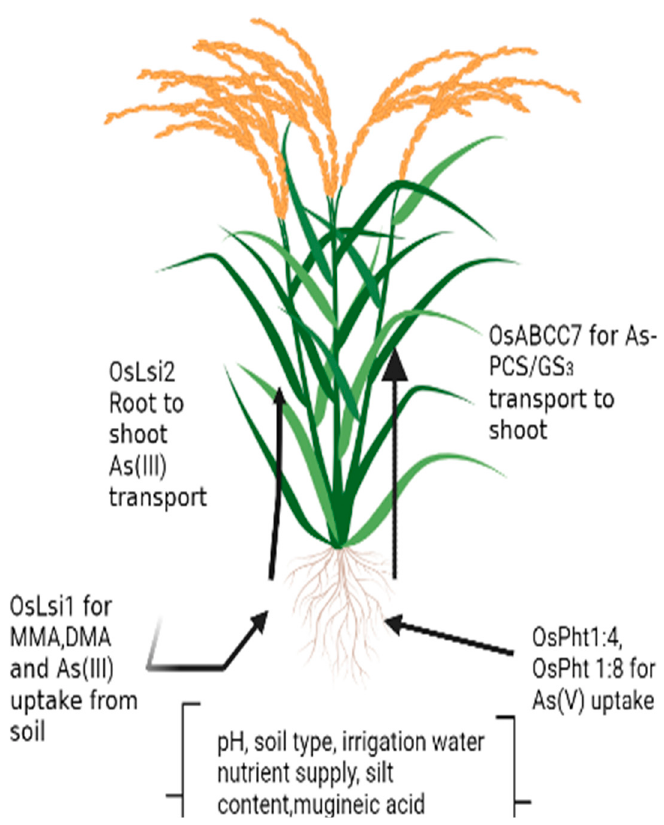
Figure 1. Different transporters for arsenic uptake, their roles, and factors affecting arsenic uptake. Low silicon rice gene 1 ( OsLsi1 ) product transfers AsIII, monomethylarsonic acid (MMA), and di ‐ methylarsinic acid (DMA) from soil to root, Low silicon rice gene 2 ( OsLsi2 ) product transfers AsIII from root to shoot, phosphate transporters ( OsPht1:4 and OsPht1:4 ) transfer arsenate from soil to root, and C ‐ type ATP ‐ binding cassette (ABC) transporter ( OsABCC7 ) transfers arse ‐ nite ‐ phytochelatins complex (AsIII ‐ PC s ) from root to shoot. Soil pH, soil type, irrigation water nu ‐ trient supply, slit content, and muginic acid affect arsenic uptake by roots. Adapted from Khan et al. [63].